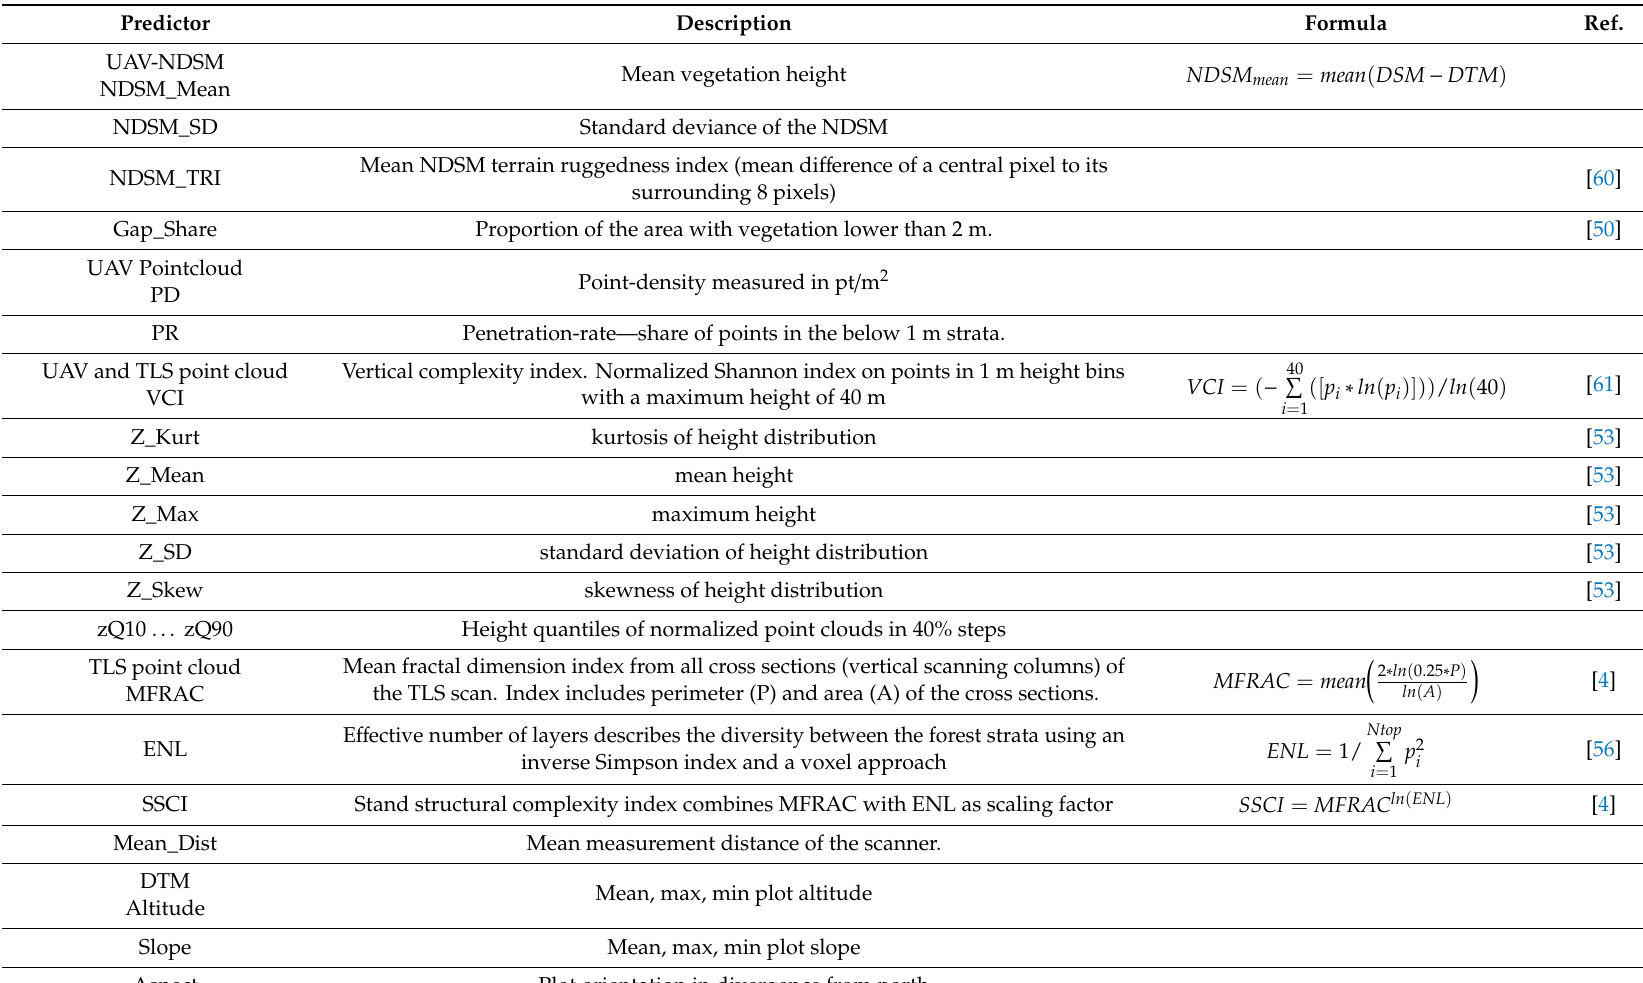
Table 1. Summary of the included remote sensing variables from UAV and TLS measurements included in the statistical